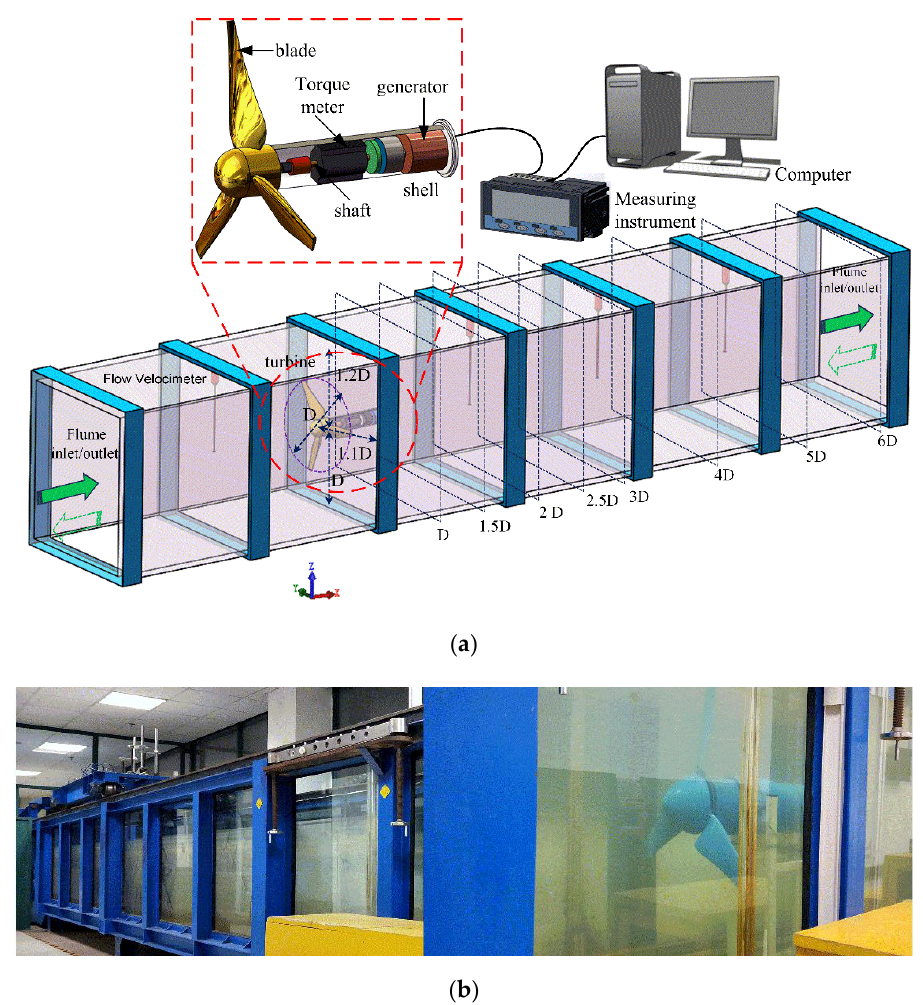
Figure 7. ( a ) Water channel ( b ) Experimental prototype.